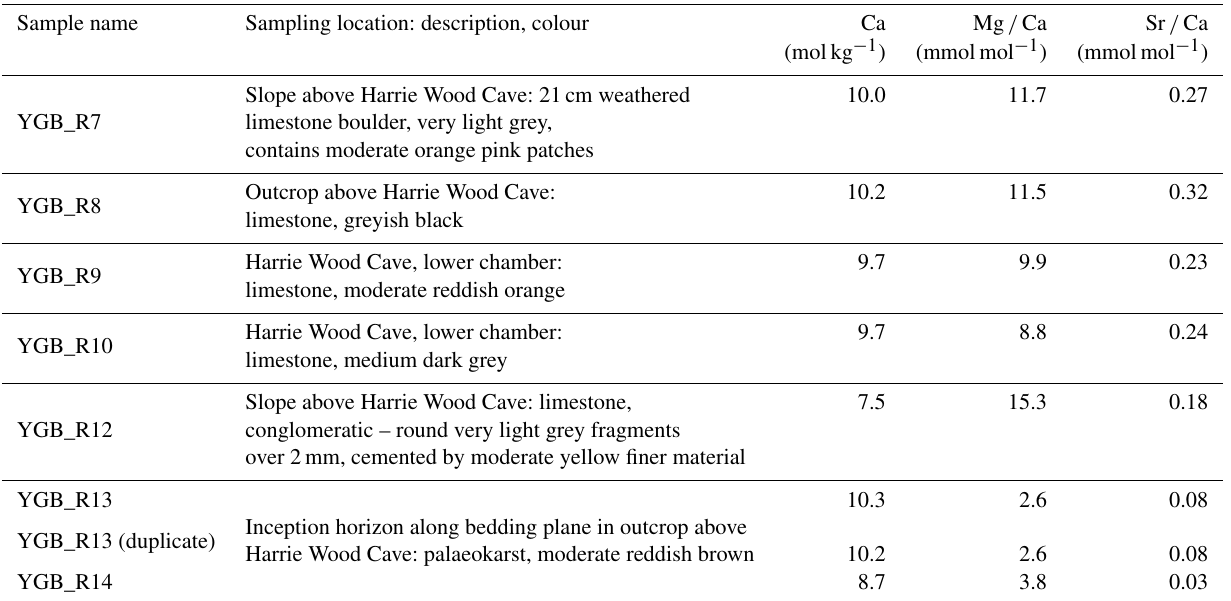
Table 2. Sample name, sampling location and description, Ca concentration (molkg − 1 ), Mg / Ca (mmolmol − 1 ) and Sr / Ca (mmolmol − 1 ) ratios in bedrock samples. On the slope above Harrie Wood Cave, representative samples were collected from the soil surface. The outcrop above the cave is located 33m west of the cave entrance along the path and at the base of the slope. Within the cave, only exposed limestone surfaces were sampled. Colours of samples are based on a visual comparison with the Munsell ® rock-colour